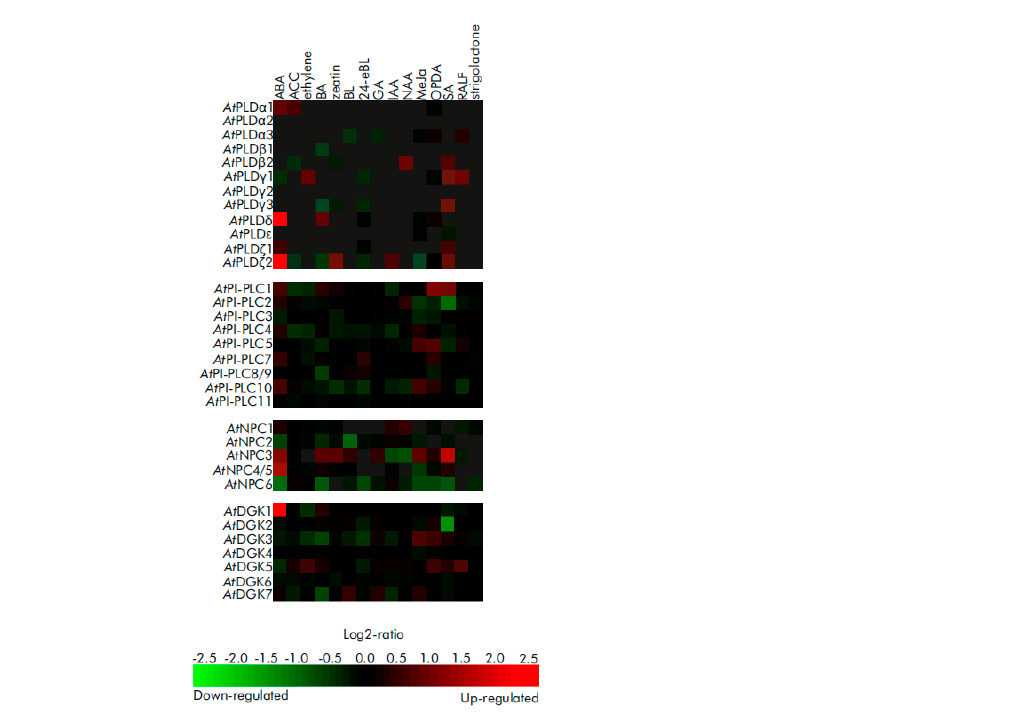
Figure 6. Meta-analysis of the expression pattern of PA-producing signaling enzymes (PLD, PI-PLC, NPC, DGK) in plants in response to phytohormones. Transcriptomic data were collected from the “Genevestigator” database [55] according to the outputs of classical array experiments (“AT_AFFY_ATH1” platform). Shown here is a heat-map of the relative values of gene expression differences between hormone-treated and mock-treated samples. All statistical data were imple- mented and provided by the “Genevestigator” database. Color saturation corresponds to the spe- cific level of upregulation (red) and downregulation (green) of gene expression. Genes and corre- sponding AGI used: At PLD α 1 (At3g15730), At PLD α 2 (At1g52570), At PLD α 3 (At5g25370), At PLD ε (At1g55180), At PLD β 1 (At2g42010), At PLD β 2 (At4g00240), At PLD γ 1 (At4g11850), At PLD γ 2 (At4g11830), At PLD γ 3 (At4g11840), At PLD δ (At4g35790), At PLD ζ 1 (At3g16785), At PLD ζ 2 (At3g05630); At PI-PLC1 (At5g58670), At PI-PLC2 (At3g08510), At PI-PLC3 (At4g38530), At PI-PLC4 (At5g58700), At PI-PLC5 (At5g58690), At PI-PLC7 (At3g55940), At PI-PLC8 (At3g47290), At PI-PLC9 (At3g47220), At PI-PLC10 (At4G34920), At PI-PLC11 (At3G19310); At NPC1 (At1g07230), At NPC2 (At2g26870), At NPC3 (At3g03520), At NPC4 (At3g03530), At NPC5 (At3g03540), At NPC6 (At3g48610); At DGK1 (At5g07920), At DGK2 (At5g63770), At DGK3 (At2g18730), At DGK4 (At5g57690), At DGK5 (At2g20900), At DGK6 (At4g28130), At DGK7 (At4g30340). Gene of At PI-PLC6 (At2g40116) was not represented in the corresponding platform. A total of 15 experiments were used for the analysis. Abbreviations, short description of experimental conditions (time of treatment, concentrations, tissue types, genotypes) and experiment ID codes for each set of experimental data (from figure left to right) are as follows: ABA, abscisic acid, 10 µ M, 3 h, seedlings, Col-0 (AT-00110); ACC, 1-aminocyclopropane-1-carboxylic acid, 10 µ M, 3 h, seedlings, Col-0 (AT-00110); ethylene, 5 ppm, 3 h, petiole samples, Col-0 (AT-00013); BA, 6-benzylaminopurine, 10 µ M, 1 h, shoot samples, Col-0 (AT-00351); zeatin, 1 µ M, 3 h, seedlings, Col-0 (AT-00110); BL, brassinolide, 10 nM, 3 h, seedlings, Col-0 (AT-00110); 24-eBL, 24-epibrassinolide, 0.1 µ M, 3 h, dark, seedling sample, Col (AT-00650); GA, gibberellic acid 3, 1 µ M, 3 h, seedlings, Col-0 (AT-00110); IAA, indole-acetic acid, 1 µ M, 3 h, seedlings, Col-0 (AT-00110); NAA, naphthaleneacetic acid (a synthetic auxin), 10 µ M, 2 h, leaf disc samples, Col-0 (AT-00392); MeJa, methyl jasmonate, 10 µ M, 3 h, seedlings, Col-0 (AT-00110); OPDA, 12-oxo-phytodienoic acid, 75 µ M, 4 h, seedlings, Col-0 (AT-00293); SA, salicylic acid, 2 mM, 1 day, seedlings, Col-0 (AT-00320); RALF, Rapid Alkalinization Factor 1 (peptide, At RALF), 1 µ M, 30 min, seedling sample, Col (AT-00679); strigolactone, GR24, 1 µ M, 90 min, max3-9 (a strigolactone deficient mutant) whole plant samples (AT-00404). Origi- nal data resources: GSE14961/E-GEOD-14961 datasets for salicylic acid-regulated gene expression (AT-00320), [132–139] for other hormones/biologically active